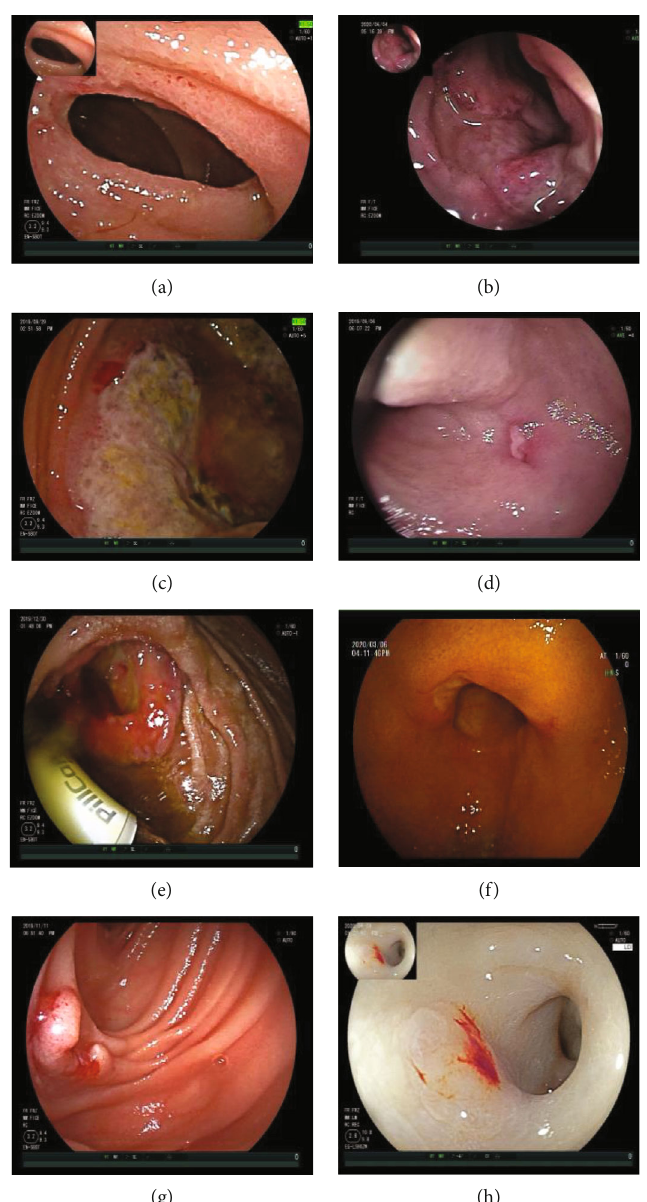
Figure 3: Double-balloon enteroscopy of patients with some other small bowel ulcerative diseases. (a) Cryptogenic multifocal ulcerous stenosing enteritis showed circular ulcer with luminal stenosis. (b) Behcet ’ s disease. (c) Lymphoma. (d) Eosinophilic enteritis. (e) Adenocarcinoma with ulcers, strictures, and capsule endoscopic retention. (f) Diverticulum with ulcer. (g) In fl ammatory granuloma with ulcer. (h) Drug (NSAID)-related ulcer (the mucosa was pale due to severe − longitudinalulcer × 2 : 164 + largeulcer × 1 : 640 Þ . We utilized the exponent of this formula and changed the 1.000; p = 0 : 044 ), skip lesions (OR: 7.254, 95% CI: 2.211- multiplicative factors into the corresponding magni fi ca- 23.795; p = 0 : 001 ), longitudinal ulcer (OR: 8.706, 95% CI: 2.360-32.120; p = 0 : 001 ), and large ulcer (OR: 0.194, 95% tion coe ffi cient. We call this formula the ISBCD index CI: 0.043-0.871; p = 0 : 032 ) were independent risk factors as follows: ISBCD index = abdominal pain ð 1, if yes Þ × for ISBCD after adjusting for interactions between variables 30 − age of onset − medication history of NSAIDs more (Table 7). In this binary logistic regression model, the prob- than two weeks ð 1, if yes Þ × 10 + skip lesions ð 1, if yes Þ × 70 + fibrinogen ð g/L Þ × 20 − D − dimer ð μ g/L Þ /10 + ability of having ISBCD was 1/ ð 1 + e 0 : 358+age×0 : 032 − abdominalpain longitudinal ulcer ð 1, if yes Þ × 80 − large ulcer ð 1, if × 1 : 240 + NSAIDsusedmorethantwoweeks × 2 : 439 − yes Þ × 10 . skiplesions × 1 : 982 − fibrinogen × 0 : 466 + D − dimer × 0 : 001